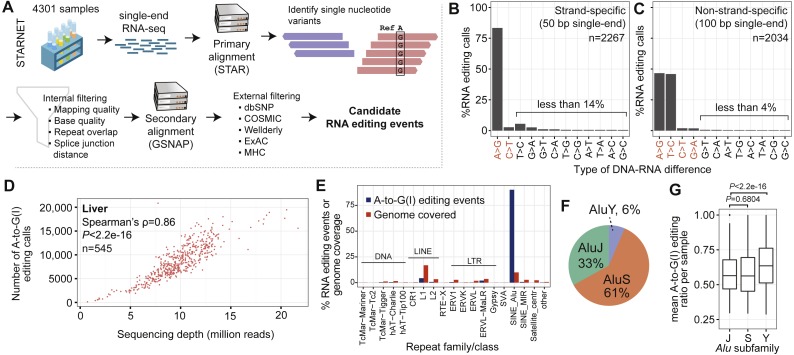
General characteristics of RNA editing events.(A) Simplified flowchart of the data analysis pipeline. See Fig. S1 for details. MHC, major histocompatibility complex. (B) Percentages of RNA editing types that were identified. The x-axis shows the editing type, and the y-axis shows the percentage of total editing calls. (The plot counts redundant sites, i.e., if the same RNA editing site is found in two samples, then the site is counted twice.) Editing events were identified in strand-specific libraries. Changes indicated in red (x-axis) are canonical events. The majority of events are consistent with A-to-I editing. (C) As (B) except that editing events were identified in non-strand-specific libraries. (D) Relationship between sequencing depth after collapsing of PCR duplicates (x-axis; million reads) and number of A-to-G(I) editing calls (y-axis). Each dot represents a liver sample from one subject. Only the non-strand-specific samples are shown. (E) Percentage of A-to-G(I) events in various genomic repeats. The repeat family/class is shown on the x-axis and identified events/genomic coverage in percent is on the y-axis. Alu is the only repeat class that shows enrichment compared with the total genomic coverage. (F) Pie chart of A-to-G(I) events in Alu subfamilies (S, Y, and J). (G) The box plot shows sample mean editing ratios of A-to-G(I) events. One outlier was removed from the Y subfamily. Editing events in Alu Y have significantly higher editing ratios compared with those in Alu J and S (Mann–Whitney U test; P < 2.2e − 16).